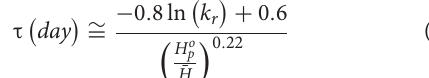
it is assumed that b in Eq. 10 is relatively negligible for a high wave